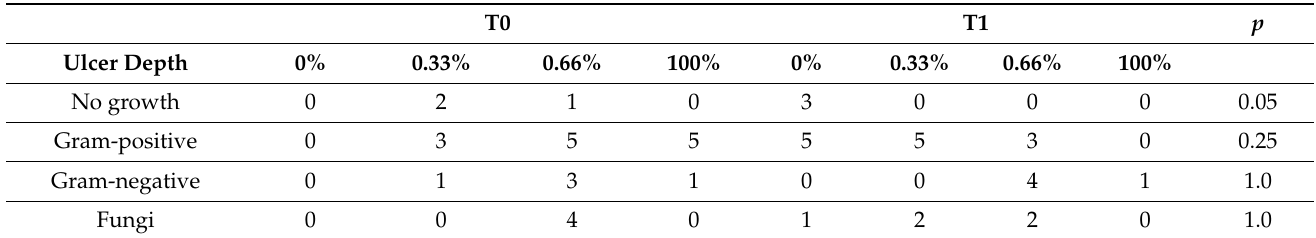
Table 2. Distribution of ulcer depth between T0 and T1, evaluated at the thinnest corneal site. T0 T1